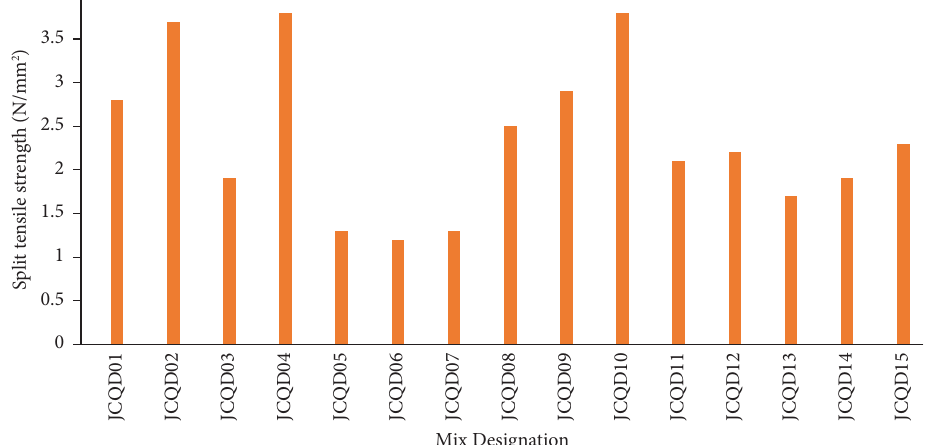
Figure 4: Concrete split tensile strength with jute fbres, coconut fbres, and quarry Figure 6. Te efect of jute fbre was higher than coconut fbre which is higher than the standard value of 2.57. Because of the bridging action between the concrete and the fbres, the tensile strength of the concrete was increased. From the responses observed, it is concluded that the addition of jute fbres improves both compressive and tensile strength compared to coconut fbres.